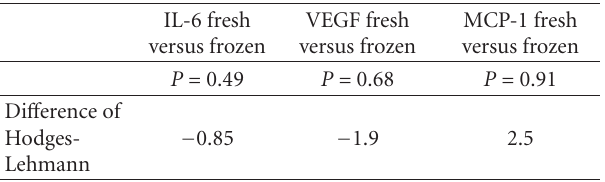
Table 2: Comparison of fresh samples and frozen stored samples using the Wilcoxon-matched pair-test including the Hodges-Lehm- ann